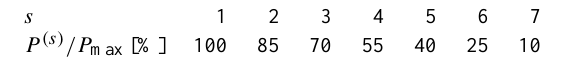
Table 3. Engine throttle levels employed in VISIR-I ( N s